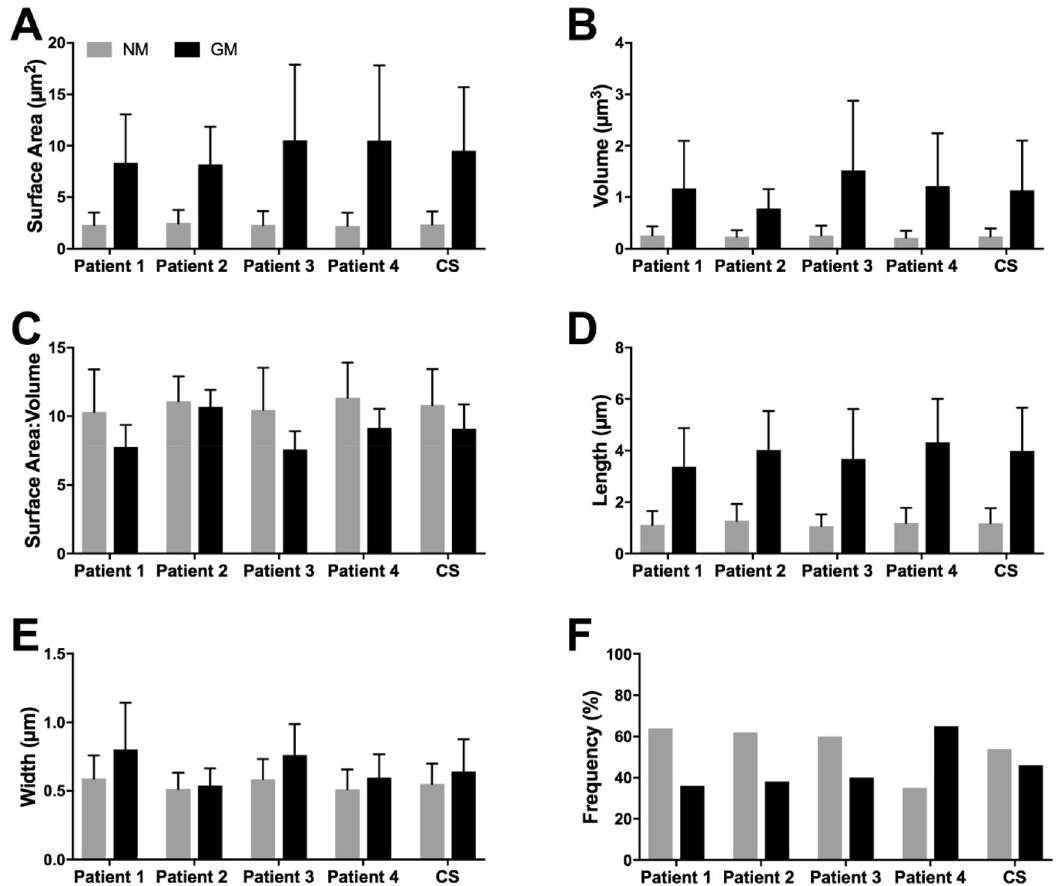
Figure 2. Quantitative comparison of a range of common morphometric parameters obtained from normal- ( n = 2451) and giant mitochondria ( n = 2081). ( A ) Mean giant mitochondria surface area (9.51 ± 6.20 µm 2 ) was 4 × greater relative to normal mitochondria (2.35 ± 1.26 µm 2 ). ( B ) On average giant mitochondria volume (1.13 ± 0.97 µm 3 ) was 4.7 × larger than normal mitochondria (0.24 ± 0.15 µm 3 ). ( C ) Surface area-to- volume ratio was 17.4% reduced between giant mitochondria and normal mitochondria. ( D ) Mean giant mitochondria length measured 3.99 ± 1.68 µm versus 1.18 ± 0.59 µm in normal mitochondria. ( E ) On average giant mitochondria were ~ 20% wider than normal mitochondria (0.64 ± 0.24 µm vs. 0.55 ± 0.15 µm). ( F ) The frequency of giant mitochondria versus normal mitochondria ranged between 36 and 65%, with a combined average of 46% for all patients. For each parameter statistical significance using Student’s t-test, P = ≤ 0.001. One- way ANOVA indicates a lack of inter-patient variability for the NM groups, P = < 0.0001. Additional tabular and graphical data derived from each of the 16 cells analysed (4 cells/patient) is also available (Supplementary Data S2–S4). Legend: CS, Combined score of all On average GM were 3.5 × longer (µ x GM length = 3.99 ± 1.68 µm; µ x NM length = 1.18 ± 0.59 µm) and 1.2 × wider than NM (µ established by Noske, et al. 48 . No attempts were made to distinguish between NM or GM in a state of fusion or fission; thus, mitochondrial length is reflective of calliper measurements (i.e. diameter max), and not total mito- chondrial length, incorporating branching/fusing segments. GM were rarely observed to measure tremendous lengths of up to 13.36 µm, representing 44% of the average HPC length (30.41 ± 9.15 µm; n = 16). Mean patient frequency measurements of GM, relative to NM, ranged between 36 and 65%, with a combined average of 46% for all patients (Fig. 2F, Supplementary Data S4). The highest GM frequency was observed in a cell from patient 4, of which 76% of the chondriome was composed of GM. Whole cell reconstruction of the entire chondriome. Segmentation, modelling and morphometric analysis of the entire chondriome—selected from a cell of interest derived from patient 4—was performed in order to comprehensively visualise (Fig. 3 and Supplementary Video 1) and quantify (Table 1) NM and GM, with functionally related structures of interest. The cellular organisation of both NM and GM were evenly distributed throughout the cytoplasm. GM displayed three directions of polarity (Fig. 3H), which were aligned with the three longitudinal facets of the sinusoid-HPC plasma membrane domain (Fig. 3A). Whilst normal-sized mito- chondria revealed a similar directionality, this was less evident due to their smaller size (Fig. 3G).